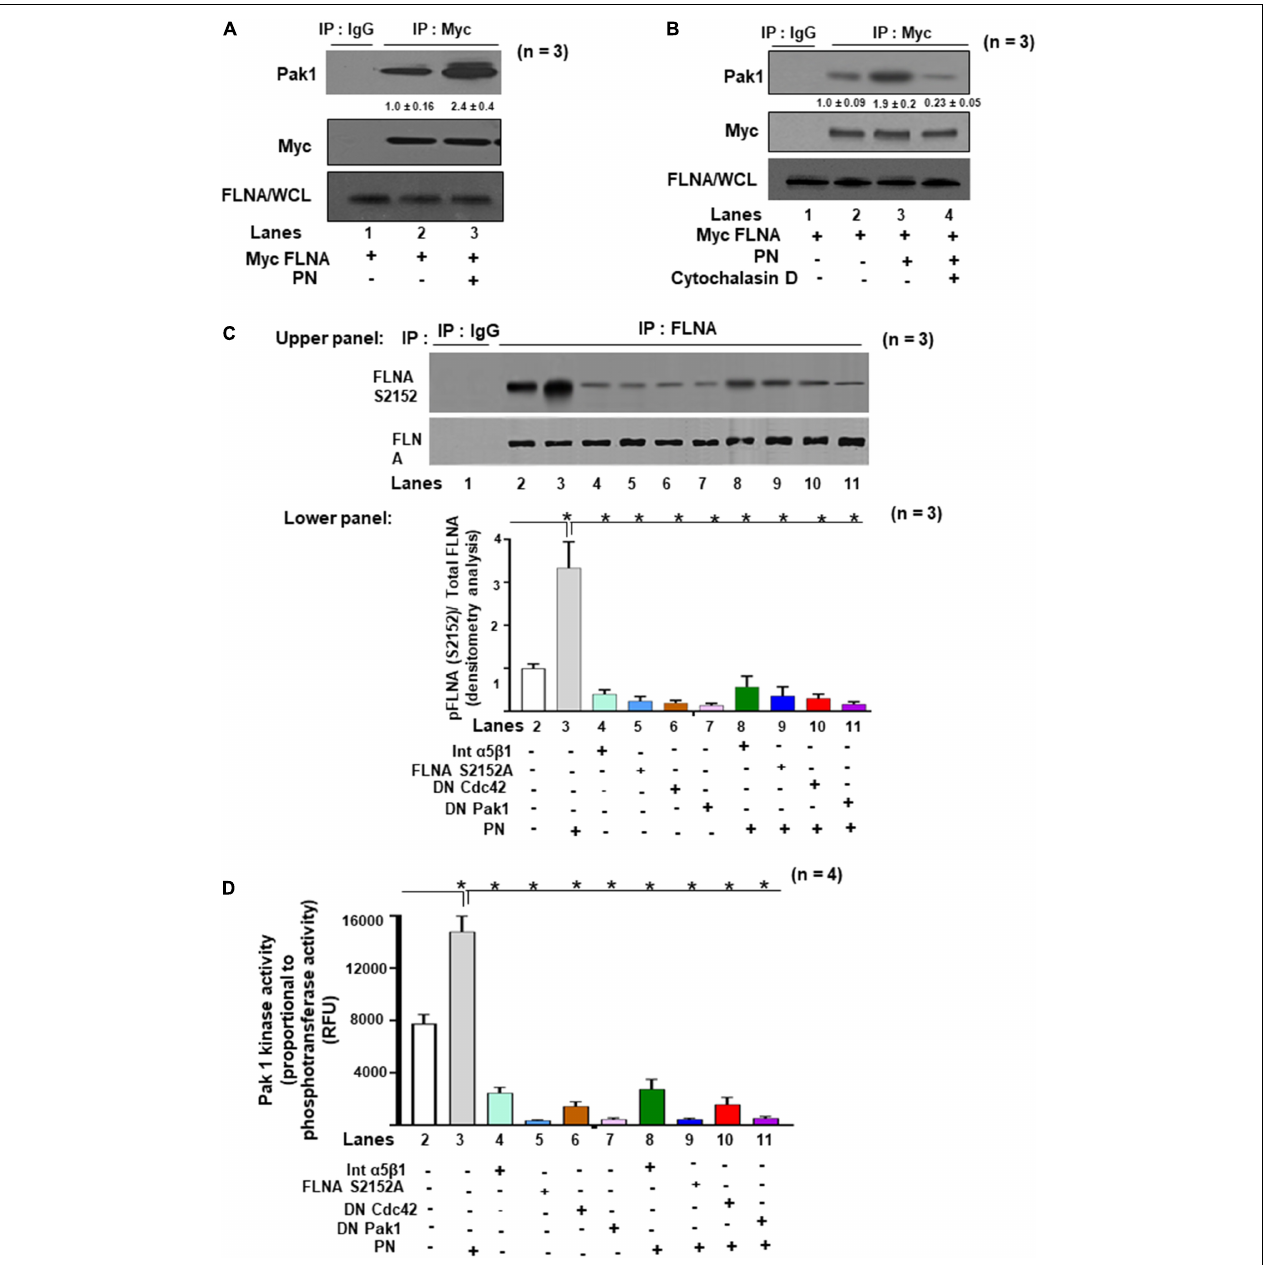
FIGURE 5 | The effects of PN/integrin β 1 on association of Pak1 with FLNA, a substrate for Pak1 kinase activity in VIC lysates. (A,B) VICs were transfected with lentivirus encoding Myc-FLNA for 48 h and then serum starved for 24 h. They were then either untreated or treated with 1 µ g/ml of PN for 1 h. (A) Cell lysates were immunoprecipitated without (lane 1, control IgG) or with an antibody against Myc (for FLNA) and immunoblotted with antibodies against Pak1, Myc, or FLNA. (B) VICs were pretreated with cytoskeleton disrupter 2 µ M cytochalasin D (CytoD) for 30 min and then treated with 1 µ g/ml PN for 1 h (lane 4) and compared with VICs treated with PN alone (lane 3). Cell lysates were immunoprecipitated with an antibody against Myc (for FLNA) and immunoblotted with antibodies against Pak1, Myc, or for FLNA in WCL. Lane 1 is for control IgG. (C) Upper Panel: VICs were cotransfected with the FLNA S2152A mutant, or DN Pak1 containing Pak1 autoinhibitory domain (residues 83–149), or DN Cdc42, or 5 µ g/ml of α 5 and β 1 integrin blocking antibodies for 2 h. After 48 h, the cells were serum starved, or treated with or without 1 µ g/ml of PN as in the experiment in Figure 2G . Pak1 was immunoprecipitated, and a nonradioactive kinase traditional in-gel phosphorylation assay was done using GST fusion proteins of FLNA as substrate. Isotype control IgG was used as control. For details, see the “Materials and Methods” section. Lower Panel: Bars represent densitometric ratios of active phospho pFLNA (S2152)/total FLNA in the lysates. (D) In vitro Pak1 kinase assays from the experiment in panel (C) were further confirmed by assaying using the nonradioactive assay kit (ab138879, Abcam), which is based on the monitoring of ADP formation (see “Materials and Methods” section for details). Data are presented as fold increase in Pak1 kinase activity with respect to control. The data in the experiments in panel (A–D) are representative of ≥ 3 independent experiments. The values in experiments (A–B) were determined by densitometry. The values derived from the control cells were designated as 1.0. Error bars are reported as means ± SD of ≥ 3 separate experiments.